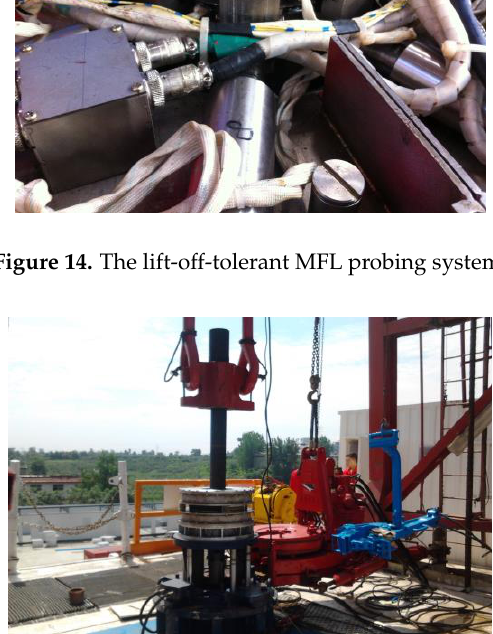
Figure 14. The lift-off-tolerant MFL probing system.